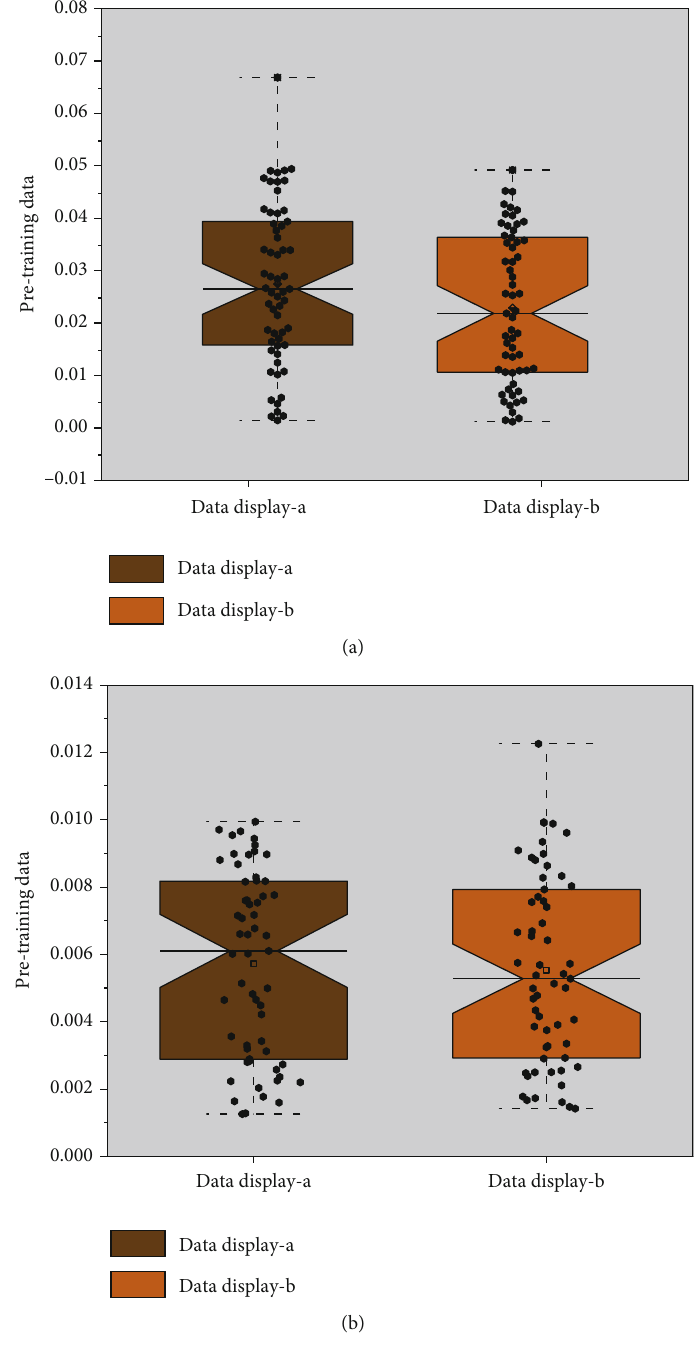
Figure 9: Comparison before and after organic integration of labor education and occupational